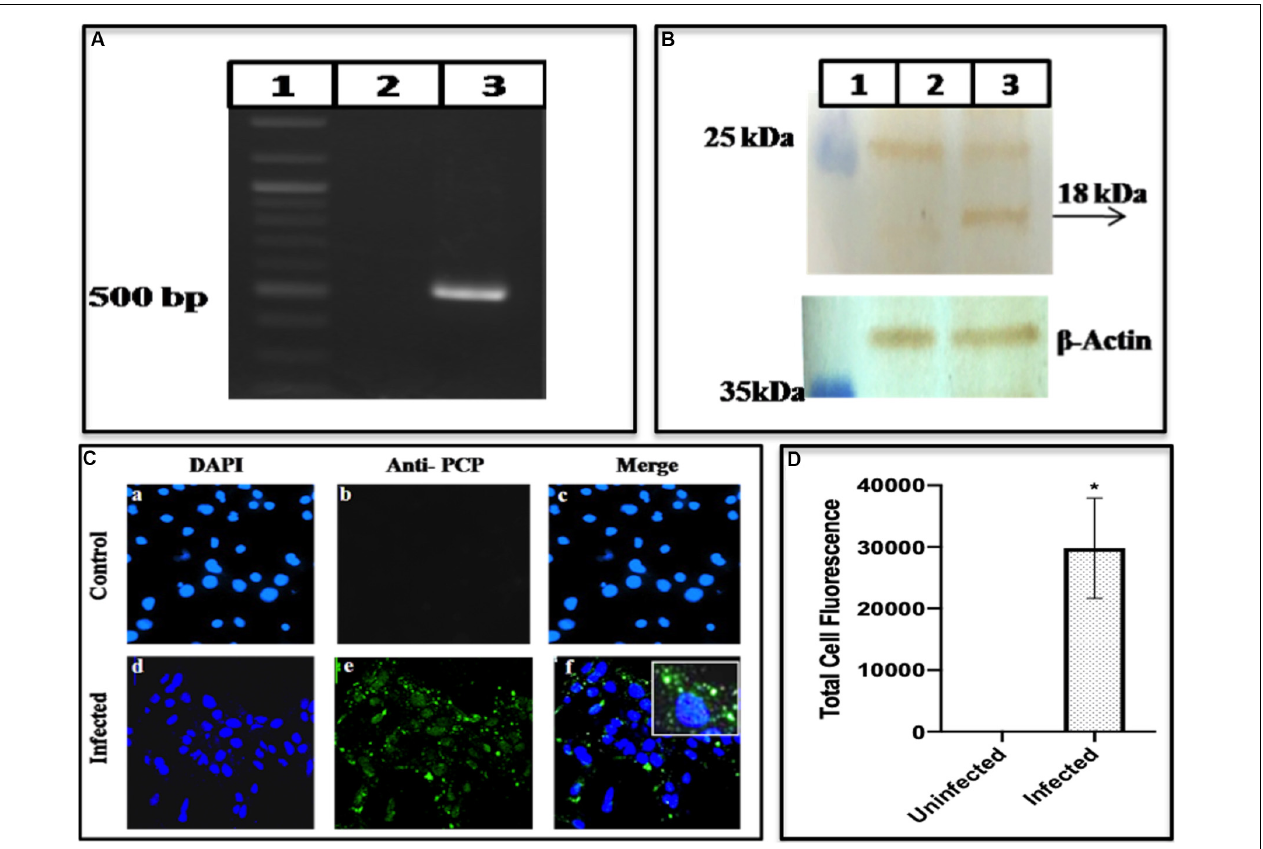
FIGURE 5 | Expression of HEV cysteine protease. (A) It represents PCR amplification of Cysteine Protease from BacMam-HEV infected cells using primers G3CPF and G3CPR ( Supplementary Table S1 ). The corresponding lanes are as follows: Marker (lane 1), cDNA from uninfected cells (lane 2), cDNA from infected cells (lane 3). (B) Western blotting analysis using Anti-Cysteine Protease antibody and Goat Anti-Rabbit IgG HRP conjugated secondary antibody. The corresponding lanes are as follows: Marker (lane 1), cell lysate from Huh7 control cells (lane 2), cell lysate from infected Huh7 cells showing specific band identical to the size of HEV Cysteine Protease (lane 3). (C) Immunofluorescence assay: Cells were stained with Anti-Cysteine Protease primary antibody, which was detected with Alexa Fluor 488 Goat Anti-Rabbit IgG secondary antibody and counterstained with DAPI to stain nuclei. Panels (a–c) represent control Huh7 cells and panels (d–f) represent HEV infected cells. Panels (c,f) represent the merged image. (D) The graph represents the mean fluorescence intensity, and the error bar indicates the standard deviation. The statistical significance was tested by the Mann–Whitney test ( p -value = 0.0286). * indicates p -value < 0.05. All the experiments were performed at least three times as independent